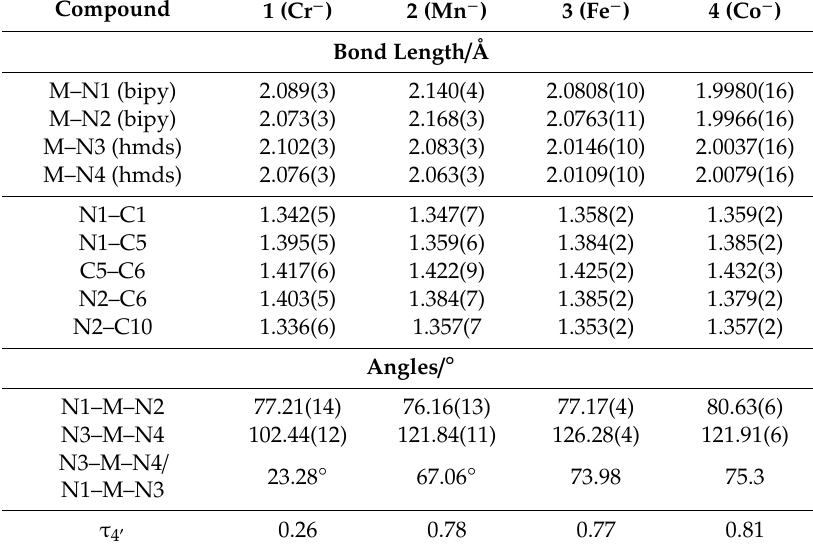
Table 1. Important structural metrics of the complex anions of the compounds 1 − 4